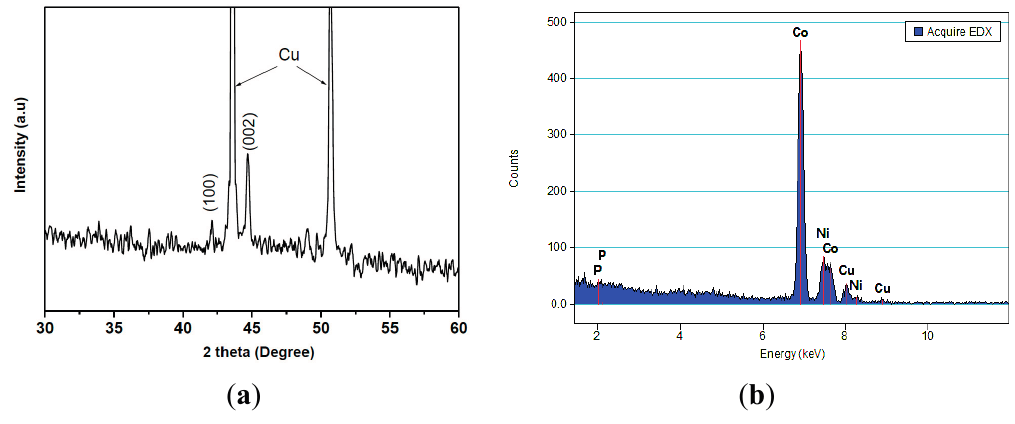
Figure 4. ( a ) XRD pattern and ( b ) EDS spectrum of the 200 nm CoNiP